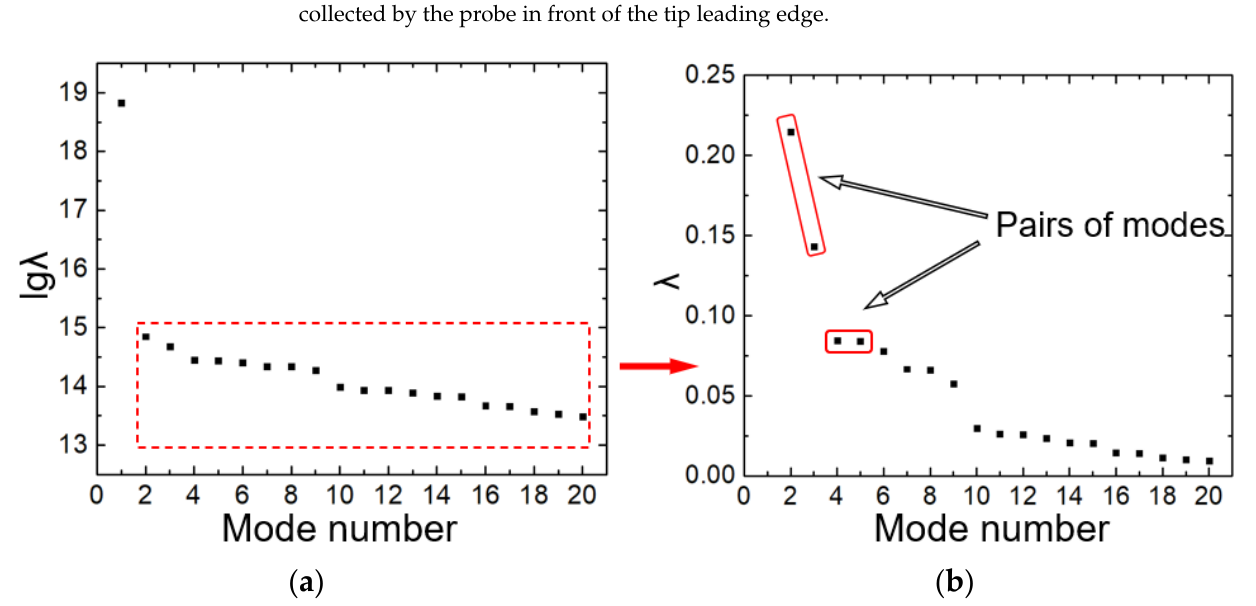
Figure 15. Distribution of mode eigenvalues by ranks. ( a ) Logarithmic eigenvalue. ( b ) Normalized eigenvalue except Mode 1.